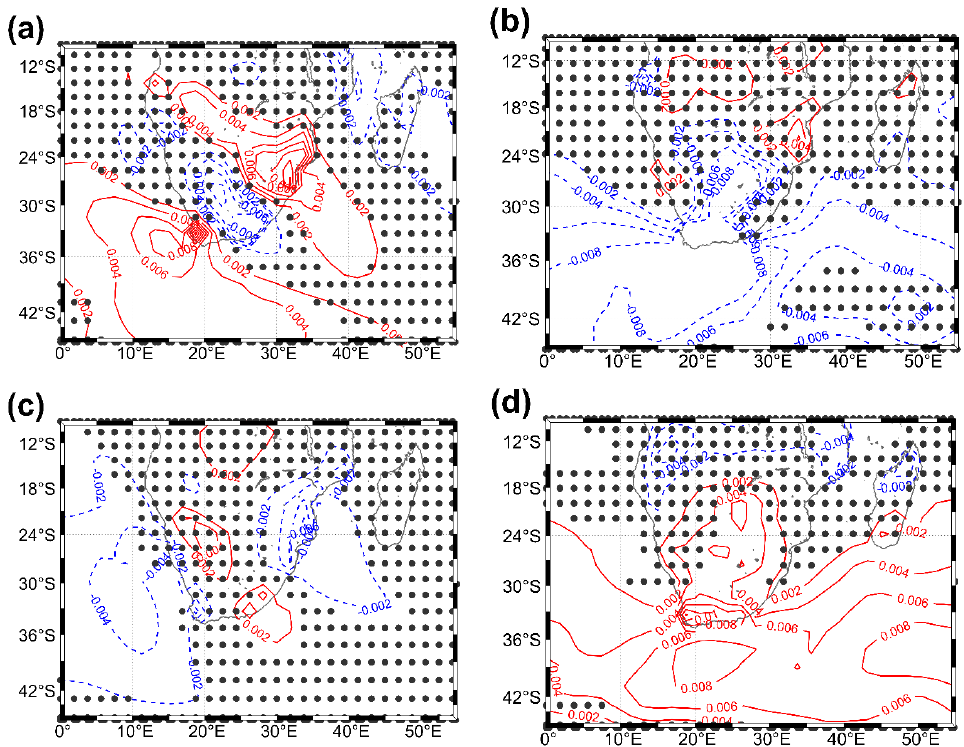
Figure 9. Regression coefficients of MEI onto ( a ) meridional wind stress and ( b ) zonal wind stress, and SAM onto ( c ) meridional wind stress and ( d ) zonal wind stress (DJF), respectively. The long-term linear trend was removed from the datasets. The base period for the analysis is 1960–2019. Dots indicate areas statistically non-significant at 90% confidence level based on p -value.